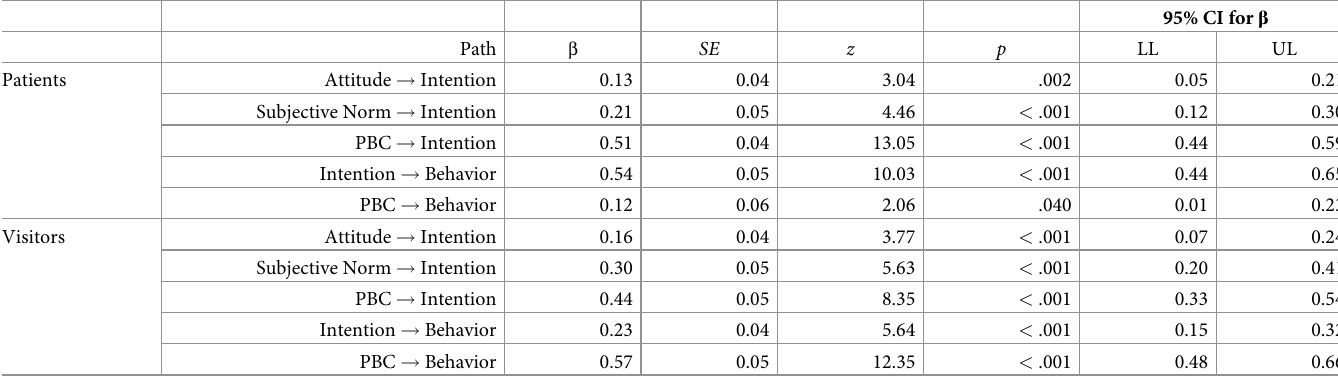
Table 1. Coefficients for the TPB path